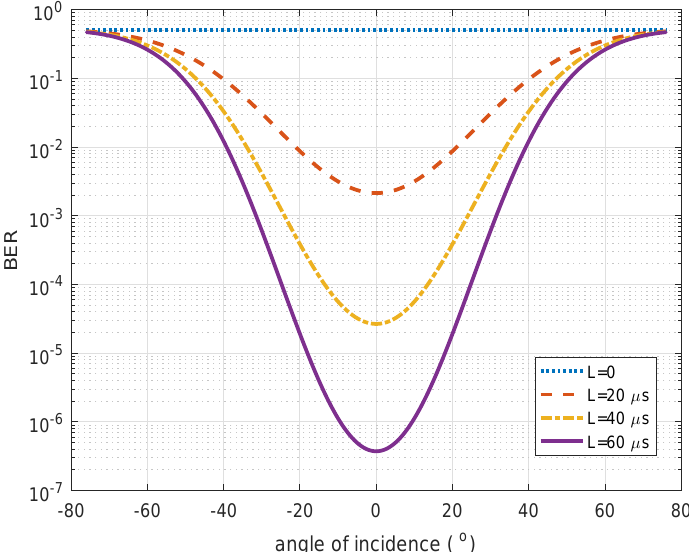
Figure 10. BER vs. angle of incidence for increasing BPC pulse length L and a minimum PDR of 0.8.